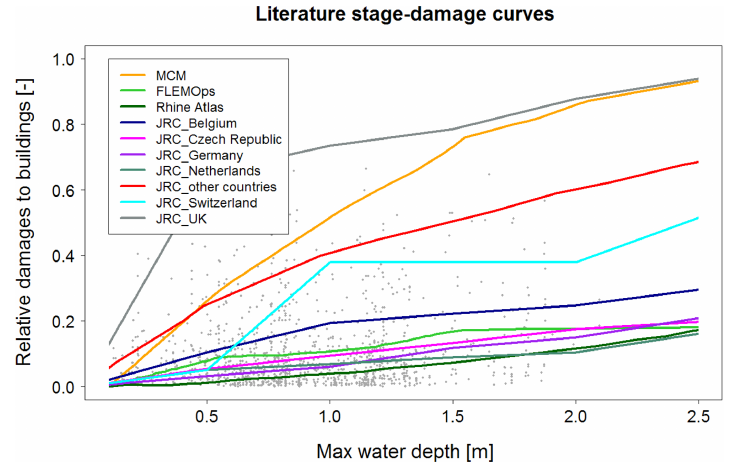
Figure 3. Literature stage-damage models and observed data: grey points in the background represent the observed relative loss (buildings only); literature models are limited to the maximum water depth reconstructed for the inundation event through the 2-D hydrodynamic model (i.e.,